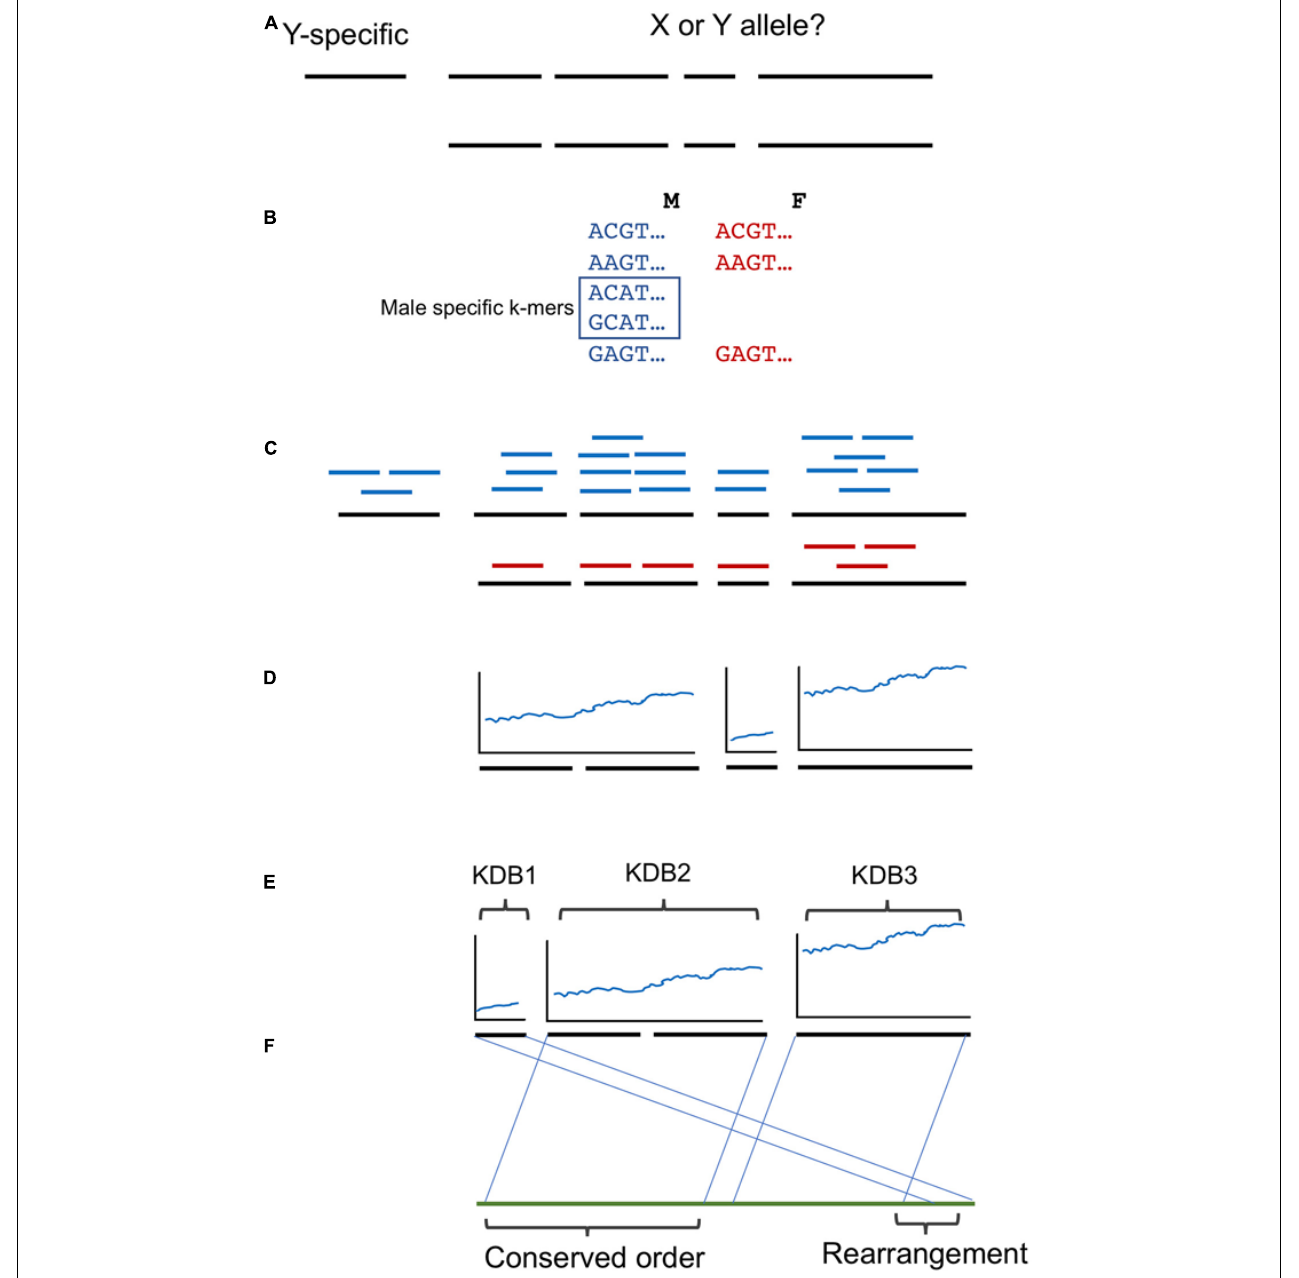
FIGURE 2 | Workflow used in this study. (A) A phased male date palm genome was used as reference. While Y specific contigs are clear by the absence of a second allele, which alleles are X or Y linked for the remainder is unclear. (B) Three male/female pairs of the western date palm subpopulation were used to identify male-specific 16 bp k-mers. (C) Contigs with one allele showing higher density of male-specific k-mers were selected as Y-linked. (D) The density of male specific k-mers was noted and (E) groups of contigs ordered by blocks of shared k-mer density (KDB). (F) The ordering was compared to oil palm and conserved ordering or rearrangements